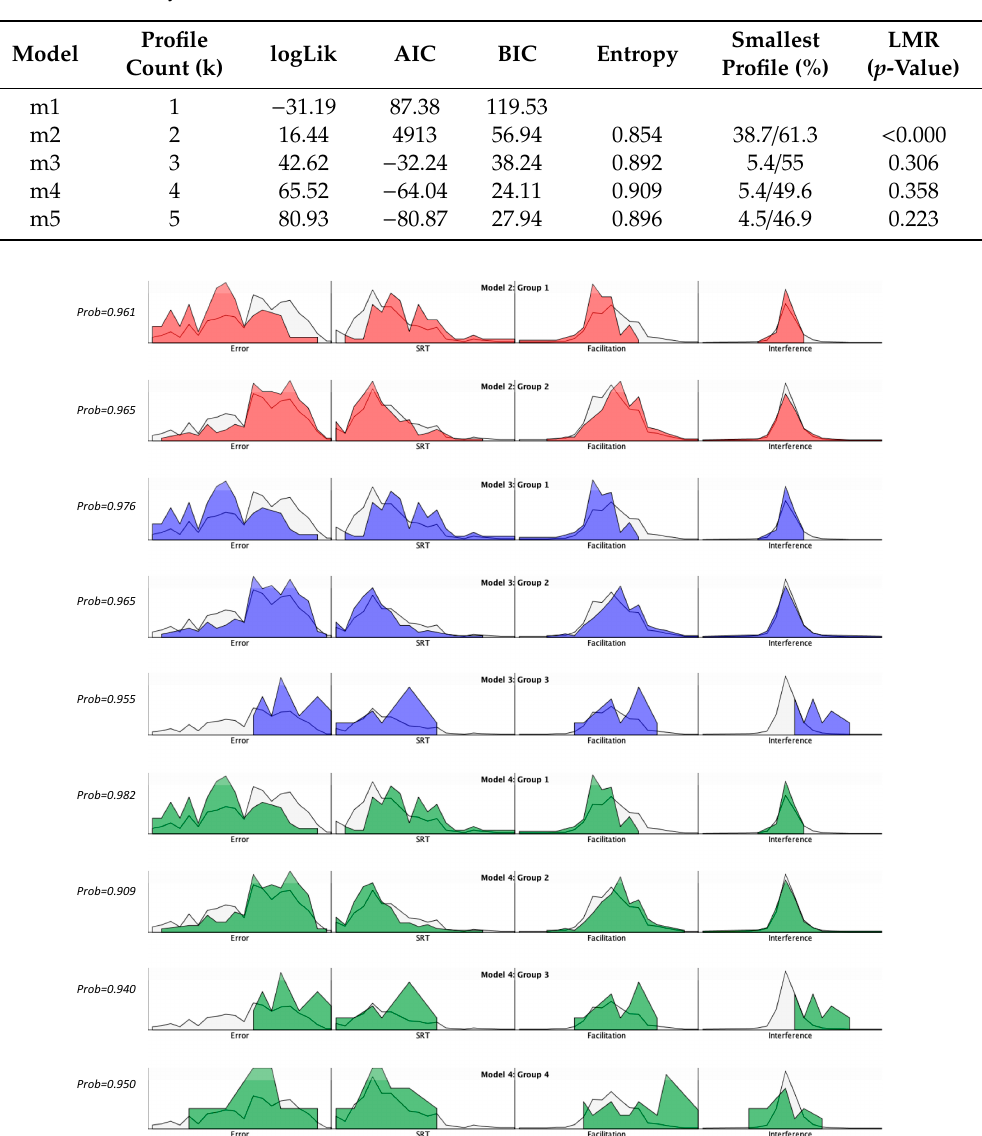
Table 1. 11-month-old latent profile analysis (LPA) model fits. Note: n = 111. The LMR test compares the current model to a model with k-1 profiles. LogLik = log likelihood; AIC = Akaike information